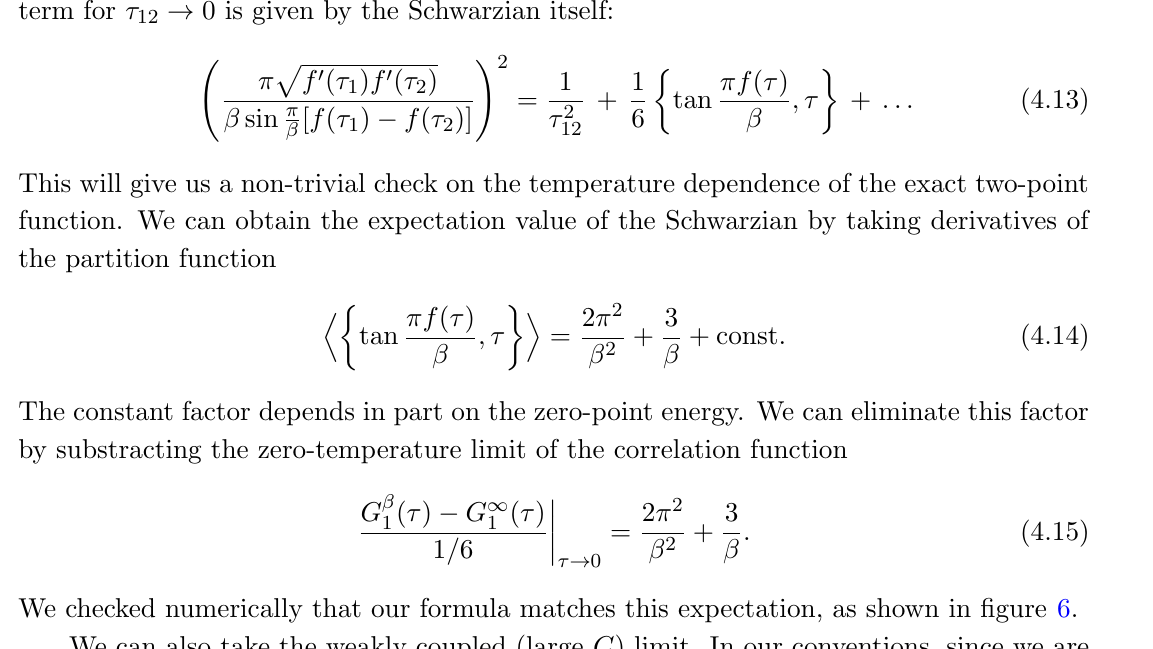
Figure 6 . Left: on the y-axis we plot the numerical evaluation of the (cid:28) G 1 ( (cid:28) )) (blue dots), which coincides with the expectation value of the Schwarzian (full black line). Right: exact two-point function for ‘ = 1 = 4, and di(cid:11)erent values of (cid:12) . We indicate the parameter g (cid:0) 2 = 2 (cid:25) . The dashed black line indicates the saddle-point result (cid:12)